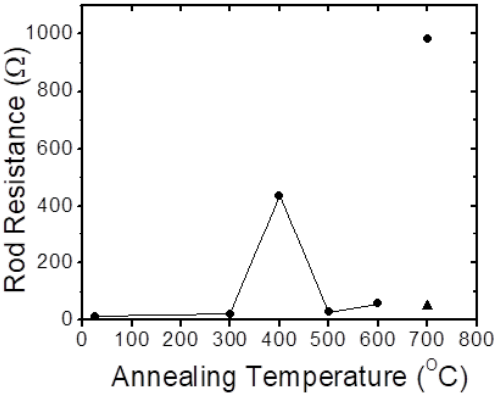
Figure 4. Rod resistances of Sample C grown on ceramic rods, as a function of annealing temperature. For 700 °C annealing, two types of temperature ramp were used. One type (circle) went up without any stop, and the other type (triangle) stopped at 400 °C, before going up to 700 °C.